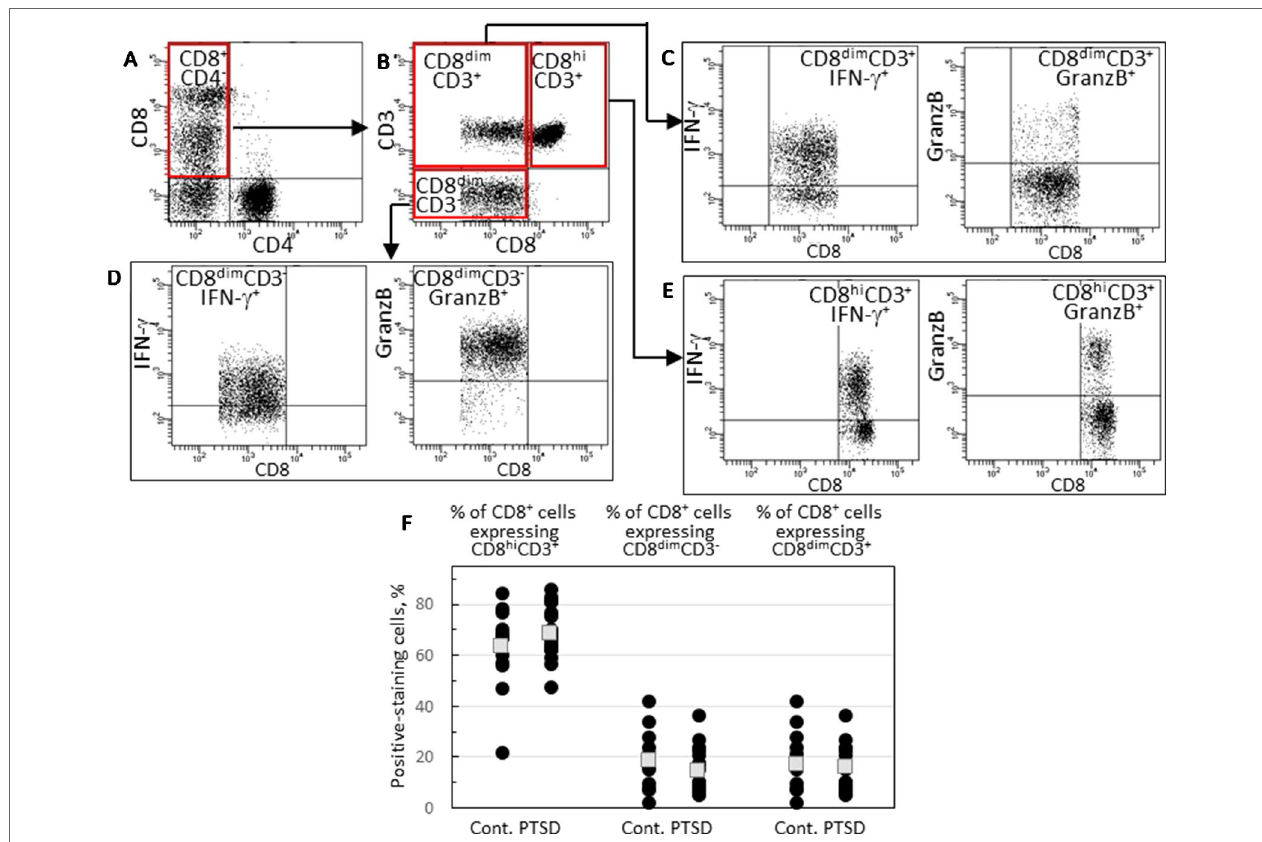
FIGURE 2 | Identification and analysis of three CD8 + cell subpopulations. (A) A typical scattergram of single lymphoid cells stained for CD8 or CD4. Cells staining positive for CD8 and negative for CD4 are identified in the quadrant that is outlined in red. (B) Gated CD8 + CD4 - cells were analyzed for CD3 and CD8 staining and were identified by the red-outlined quadrants as cells that stain bright for CD8 and stain for CD3 (CD8 hi CD3 + ), cells that stain dimly for CD8 and stain for CD3 (CD8 dim CD3 + ) and cells that stain dimly for CD8 but do not stain for CD3 (CD8 dim CD3 - ). (C) Strategy to analyzed gated CD8 dim CD3 + cells for expression of IFN- γ or granzyme B. (D) Strategy to analyzed gated CD8 dim CD3 - cells for expression of IFN- γ or granzyme B. (E) Strategy to analyzed gated CD8 hi CD3 + cells for expression of IFN- γ or granzyme B. (F) Comparison of levels of CD8 hi CD3 + , CD8 dim CD3 - or CD8 dim CD3 + subpopulations. Shown as black circles are data for each research subject, with the mean values shown as